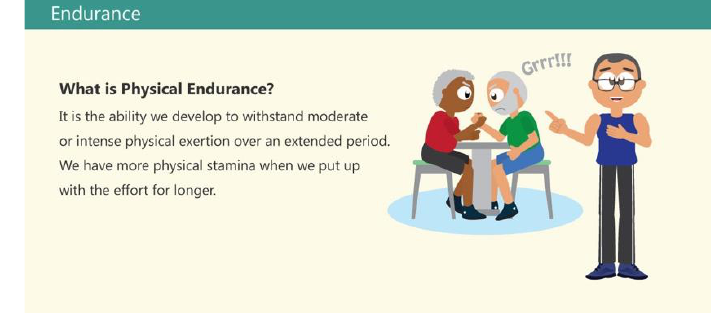
Figure 1. Example of screen that shows the definition of physical